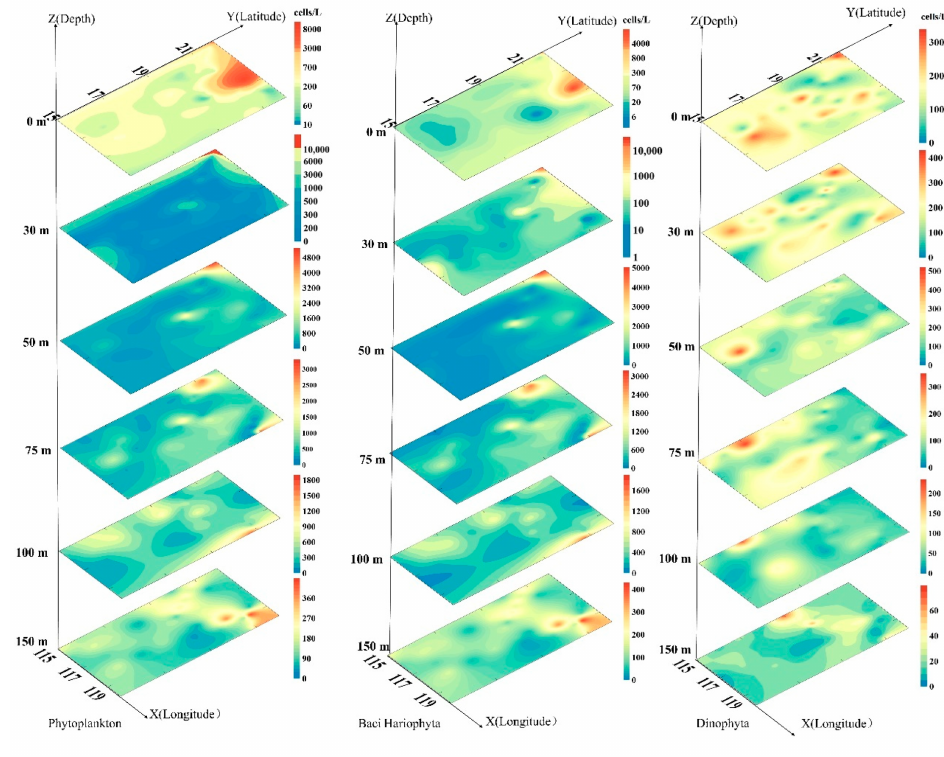
Figure 3. The cell abundance of total phytoplankton, diatoms, and dinoflagellates in the six water layers at sampling stations in the northern South China